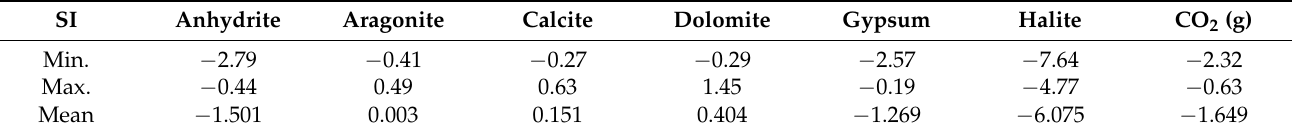
Table 5. Statistical description of the mineral SI for the obtained GW